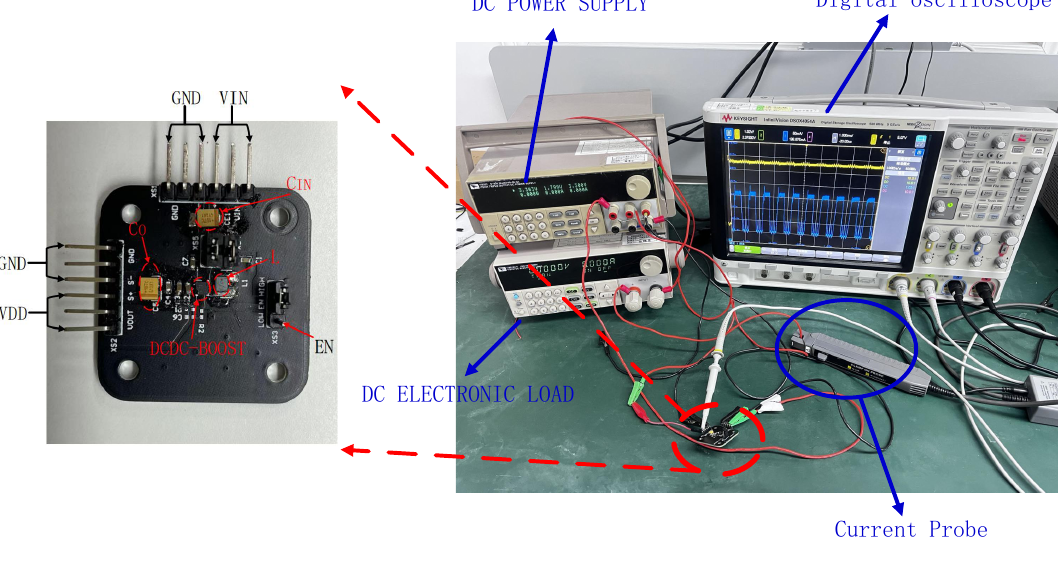
Figure 13. The test bench of the boost converter and the PCB board used for